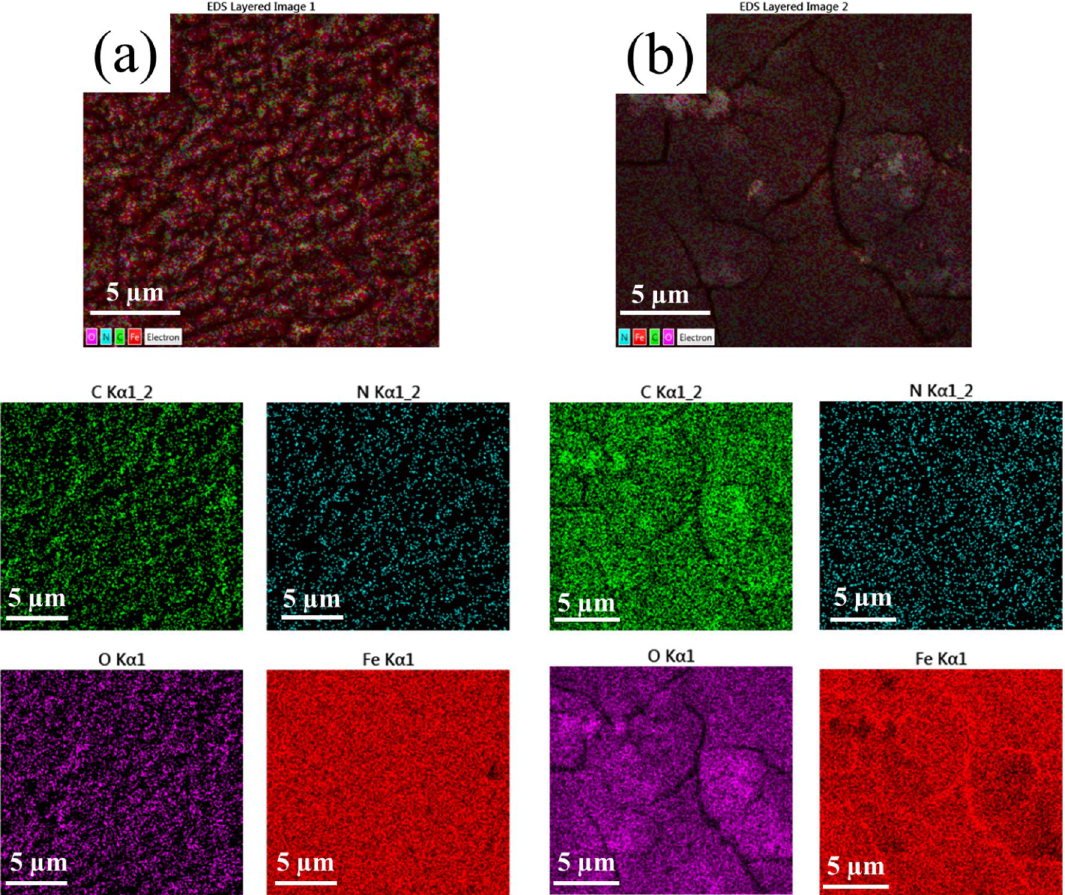
Figure 6. Map analysis of the MS surface immersed in 1 M HCl solution without ( a ) and with ( b ) 1000 ppm DPH after 4 h.